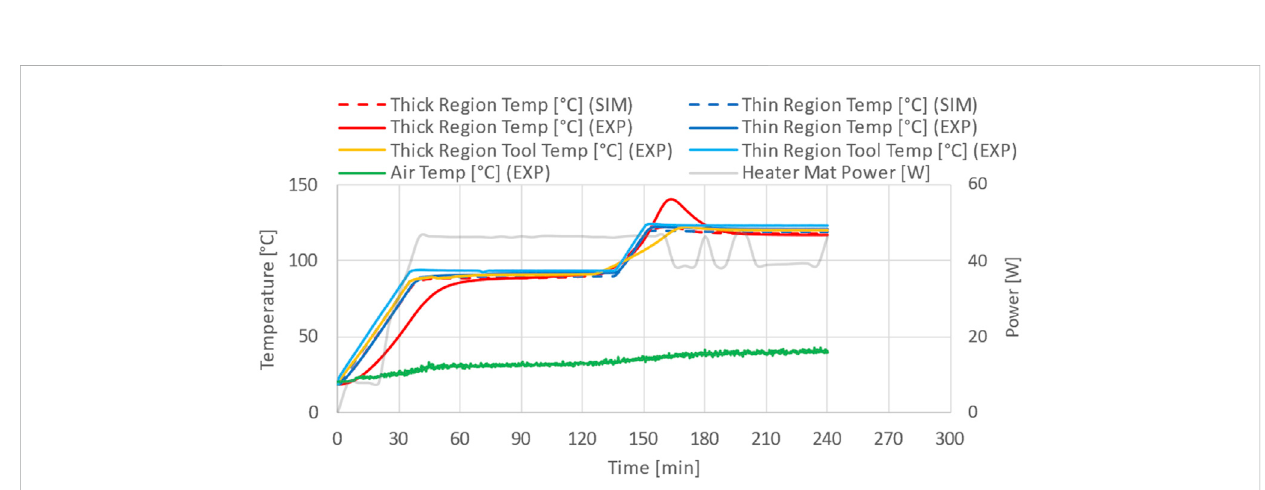
FIGURE 6 Temperature as simulated and experimentally measured at mid-thickness in thick and thin region for dual zone cure, accompanied by the power usage of the heater mats as